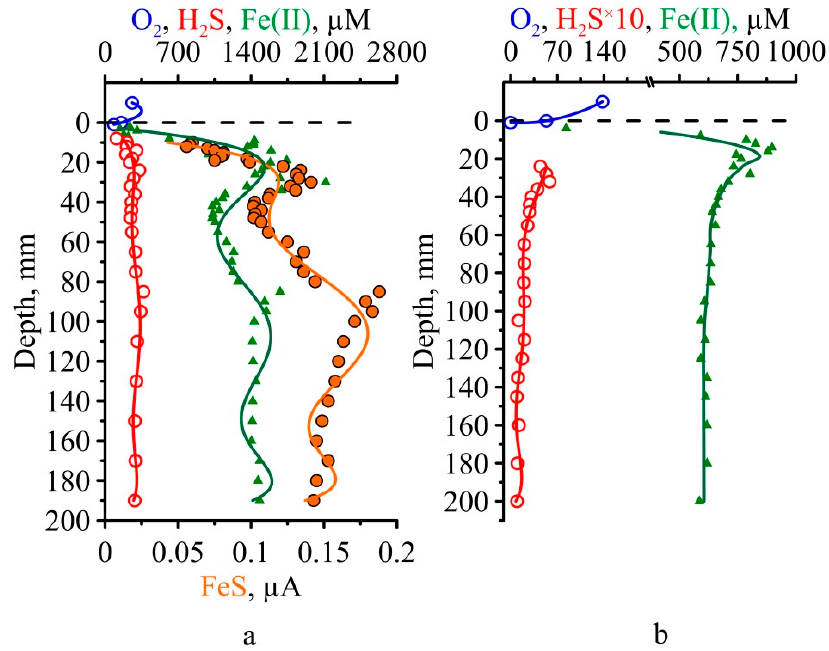
Figure 6. Vertical distribution of pore water components of bottom sediments in the Feodosiya Gulf: ( a ) St. 73; ( b ) St. 88a.